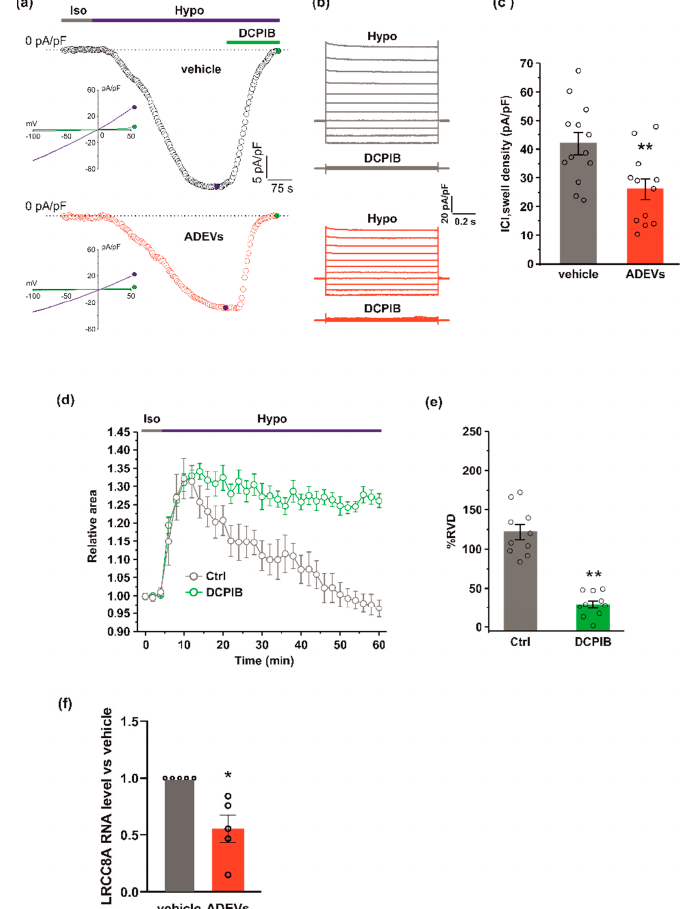
Figure 3. ADEVs reduce I Cl,swell and the LRCC8A expression in GL261 cells. ( a ) Representative time courses of I Cl,swell density (pA/pF) measured from current ramps at − 80 mV, the equilibrium potential for K+ under our recording conditions, during the application of a 30% hypotonic solution (Hypo, blue bar) and after the addition of 10 µ M DCPIB (green bar), in vehicle-treated GL261 cells (vehicle, black circles, top) and in ADEVs-treated GL261 cells (ADEVs, red circles, bottom). Insets: representative current ramps from − 100 to 50 mV (600 ms duration) from a holding potential of − 40 mV, under a 30% hypotonic solution (blue trace) and a 30% hypotonic solution containing 10 µ M DCPIB (green trace). ( b ) Representative families of current traces evoked by applying 1 s voltage steps from − 100 to 120 mV, in steps of 20 mV, from a holding potential of − 40 mV in the presence of a 30 %hypotonic solution, and in the presence of a hypotonic solution containing 10 µ M DCPIB, in vehicle-treated (grey traces, top) and in ADEVs-treated (red traces, bottom) GL261 cells. ( c ) Bar plot showing the average current density measured at - 80 mV during exposure to a 30% hypotonic solution, in vehicle- ( n = 13) and ADEVs-treated ( n = 12) GL261 cells. Data are shown as a mean ± SEM; ** p < 0.01. ( d ) Time course of RVD as evaluated from the changes of the relative cell area in vehicle conditions (Iso, grey bar) and during the application of a 30% hypotonic solution (Hypo, blue bar) to vehicle-treated GL261 cells, either in the absence (Ctrl, grey circles, n = 20) or presence of 10 µ M DCPIB (green circles, n = 10). ( e ) Bar plot showing the average percentage of RVD in GL261 cells in the absence (Ctrl) or presence of 10 µ M DCPIB (DCPIB), calculated as follows: %RVD = (Arel,peak − Arel,56 min)/(Arel,peak)) × 100. Data mean ± SE; Student’s t -test ** p < 0.0001. ( f ) qPCR of LRCC8A gene in vehicle-treated GL261 cells (vehicle) or GL261 cells treated with ADEVs. Data are the mean ± SE of fold increase vs. vehicle, normalized on gapdh (used as a housekeeping gene); N = 5; * p < 0.05 vs. ctrl; by using the Mann–Whitney rank sum